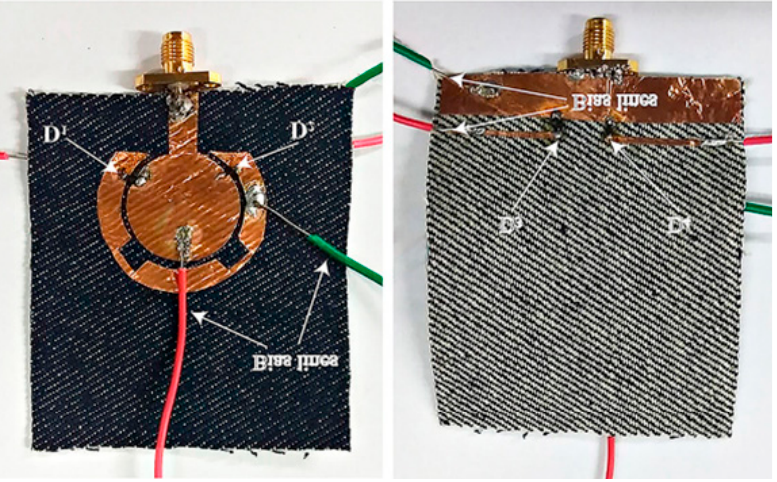
Figure 8. Fabricated prototype of the frequency and polarization-reconfigurable antenna on jean substrate in [109].